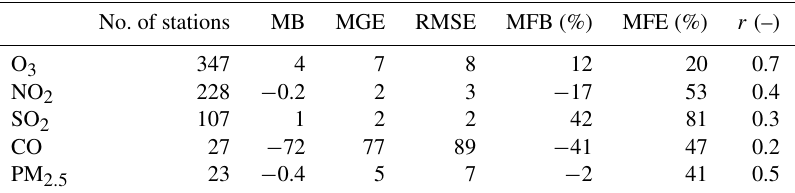
Figure 3. Diurnal profiles of surface O 3 mixing ratios in eight European regions in summer 2010. The number of stations available for each region is reported in parentheses at the top of each panel. A definition of the regions is given in Fig. 1. Table 5. Model performance evaluation for the daily mean concentrations of the chemical species in summer (JJA) 2010. The units for MB, MGE and RMSE are in ppb for the gas species and in µgm − 3 for PM 2 . 5 . No. of stations